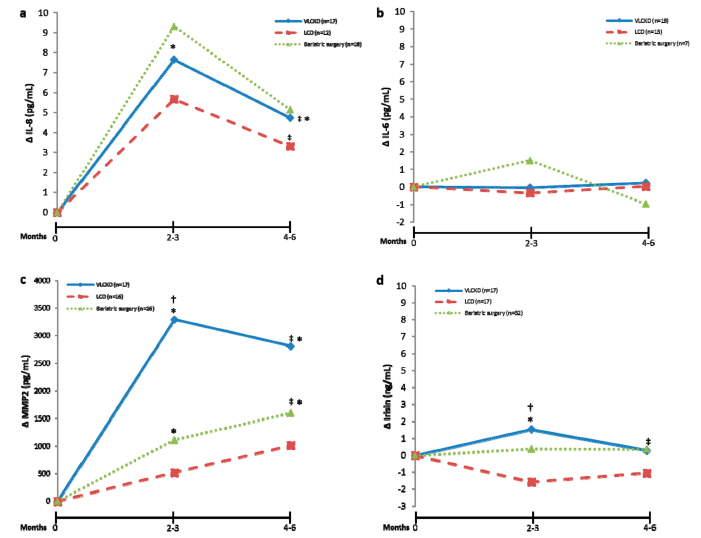
Figure 3. Changes in circulating myokine levels during a very-low calorie ketogenic diet (VLCKD), a low-calorie diet (LCD) or bariatric surgery. ( a ) Changes compared to baseline in interleukin (IL)-8 during the weight loss treatments. ( b ) Changes compared to baseline in circulating IL-6 levels during the weight loss treatments. ( c ) Changes compared to baseline in circulating metalloproteinase-2 (MMP2) levels during the weight loss treatments. ( d ) Changes compared to baseline in circulating irisin levels during the weight loss treatments. Data show di ff erences compared to baseline during the time-course of the intervention. ‡ Statistically significant di ff erences over the duration of the nutritional program (from 0 to 4–6 months) evaluated with repeated-measures ANOVA or ANCOVA adjusted for age, as applicable. * Statistically significant di ff erences in relation to baseline evaluated by Student’s t -test within each weight loss treatment. † Statistically significant di ff erences among the three therapeutic procedures to lose weight evaluated by univariate